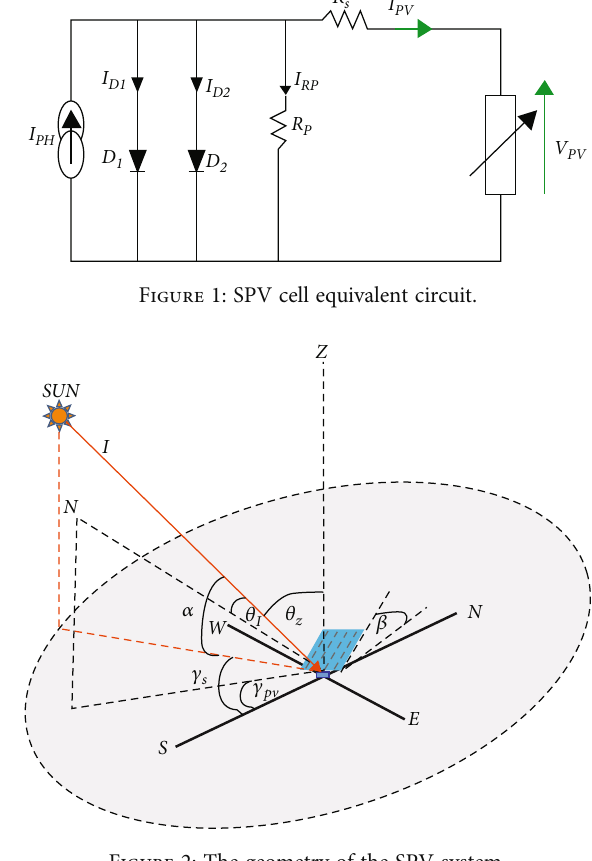
Figure 2: The geometry of the SPV